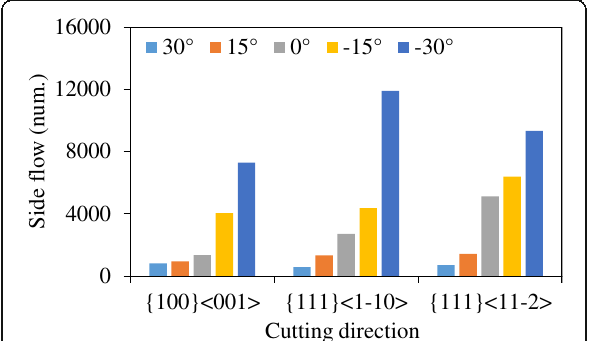
Fig. 14 Number of atoms flow to the side of tool edge with different rake angle